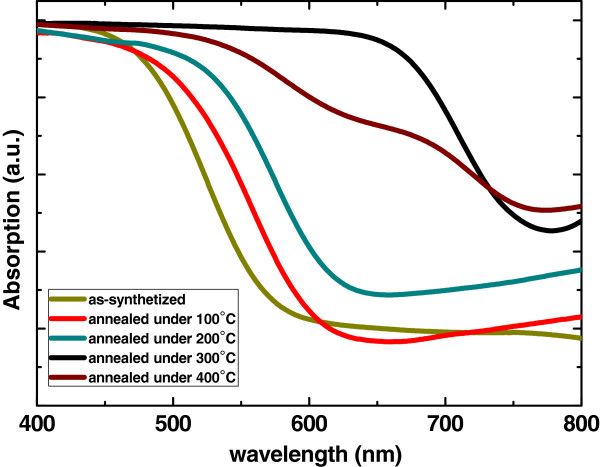
Optical absorption spectra of Sb2S3-TiO2 nanostructure samples. Before (green spectrum) and after being annealed at 100°C (red spectrum), 200°C (blue-green spectrum), 300°C (black spectrum), and 400°C (brown spectrum).